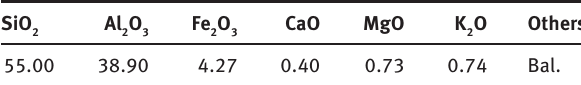
Table 2: Chemical composition of FACs (wt.%).